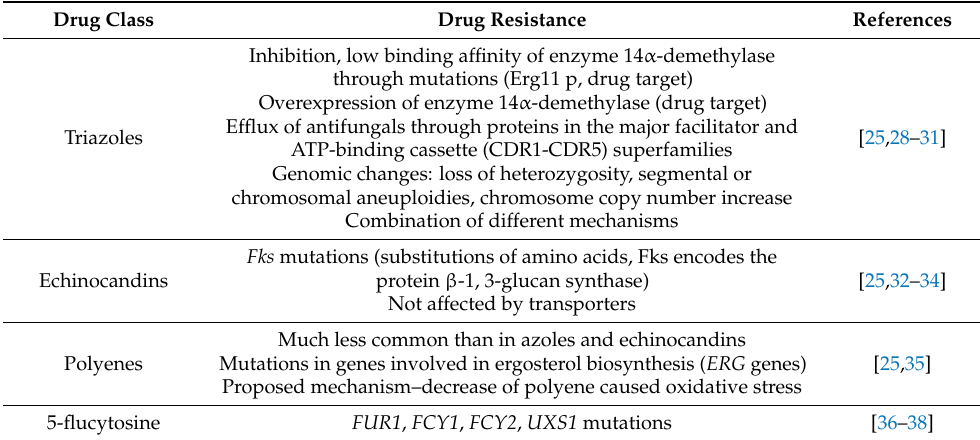
Table 2. Antifungal drugs resistance